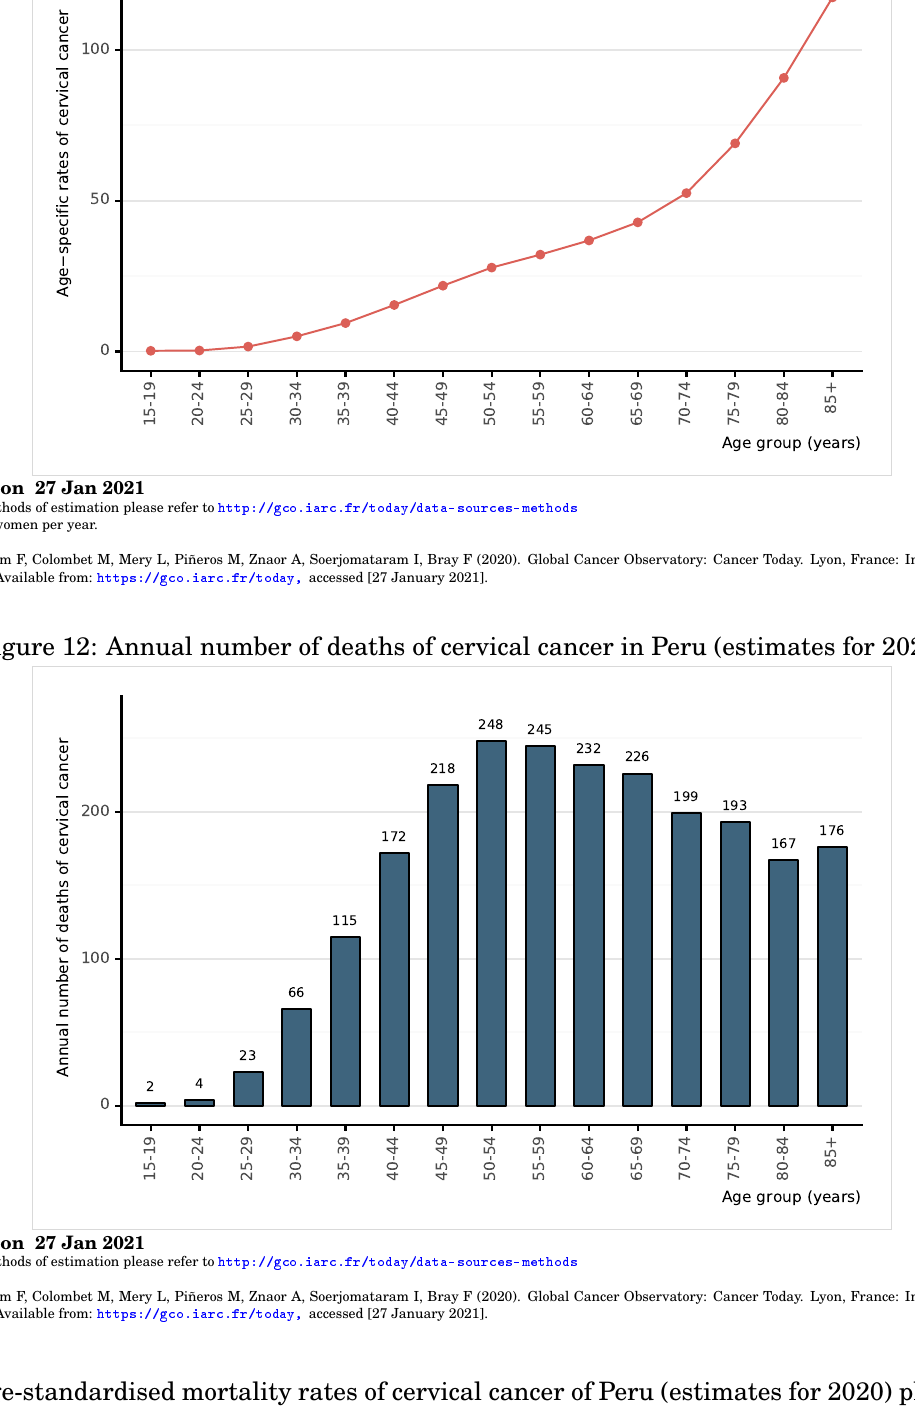
• For age-standardised mortality rates of cervical cancer of Peru (estimates for 2020) please refer to Figure 105 • For annual number of deaths of cervical cancer by age group in Peru (estimates for 2020) please refer to Figure 106 • For comparison of age-specific cervical cancer mortality rates in Peru, within the region, and the rest of world please refer to Figure